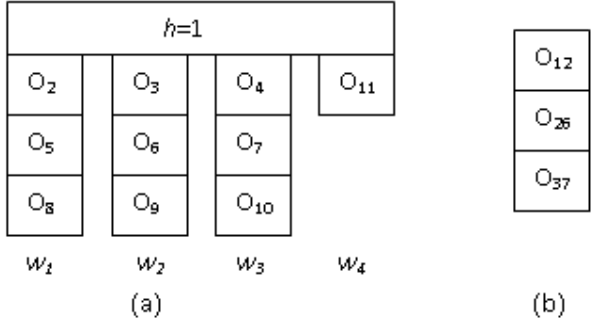
Figure 4. Genetic algorithm chromosome. ( a ) For first product. ( b ) Final assembly of all products.